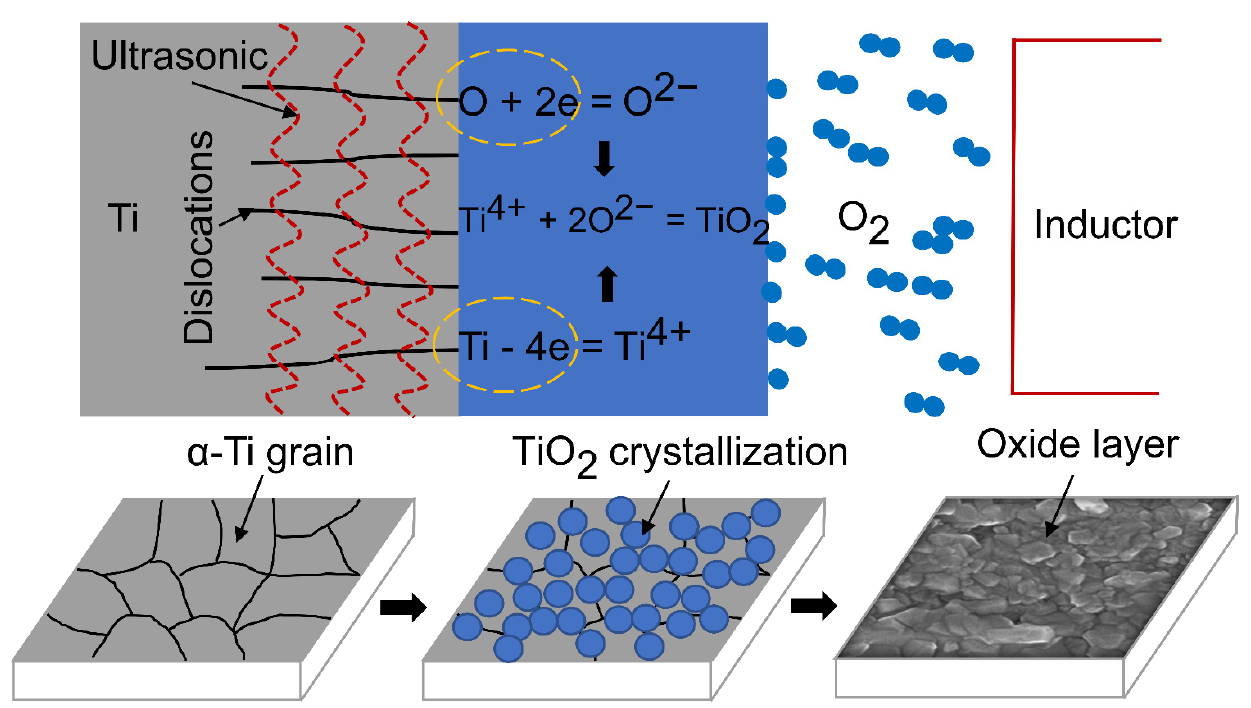
Figure 9. Schematic diagram of ultrasonic induced refinement of induction heated oxide coating on titanium.